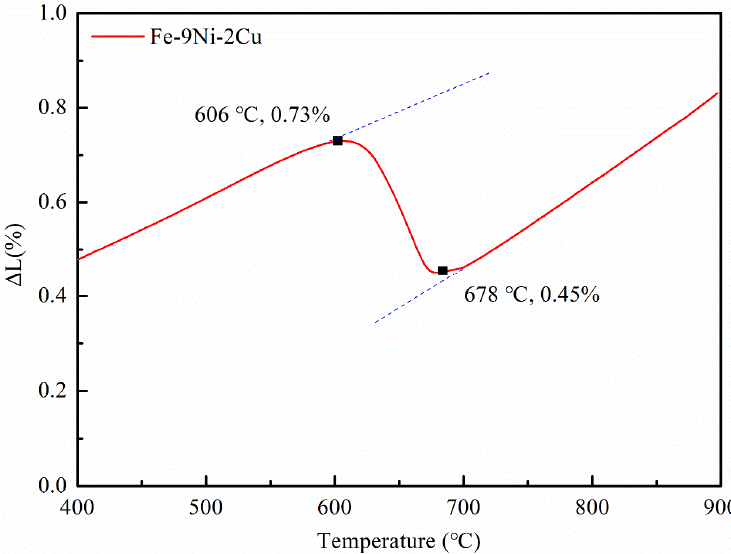
Figure 1. Phase transformation temperature of Fe-9Ni-2Cu steel measured by thermal expansion methods.